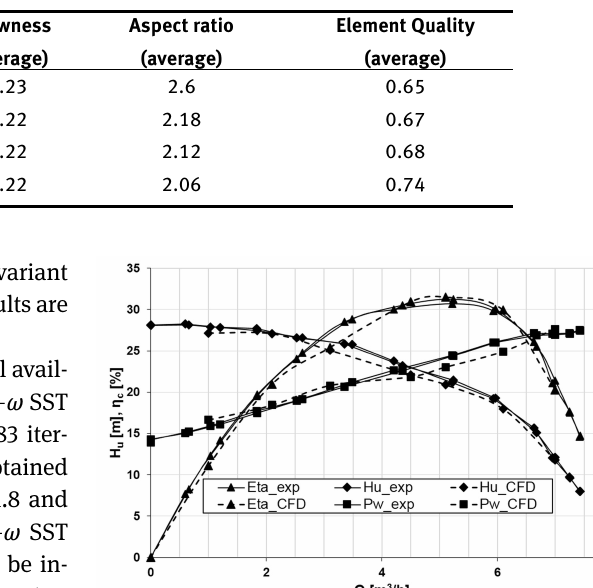
Table 1: Properties of computational grids for each variant